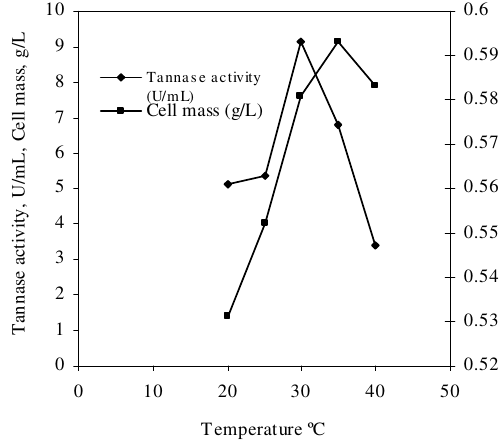
Figure 3. Effect of temperature on tannase